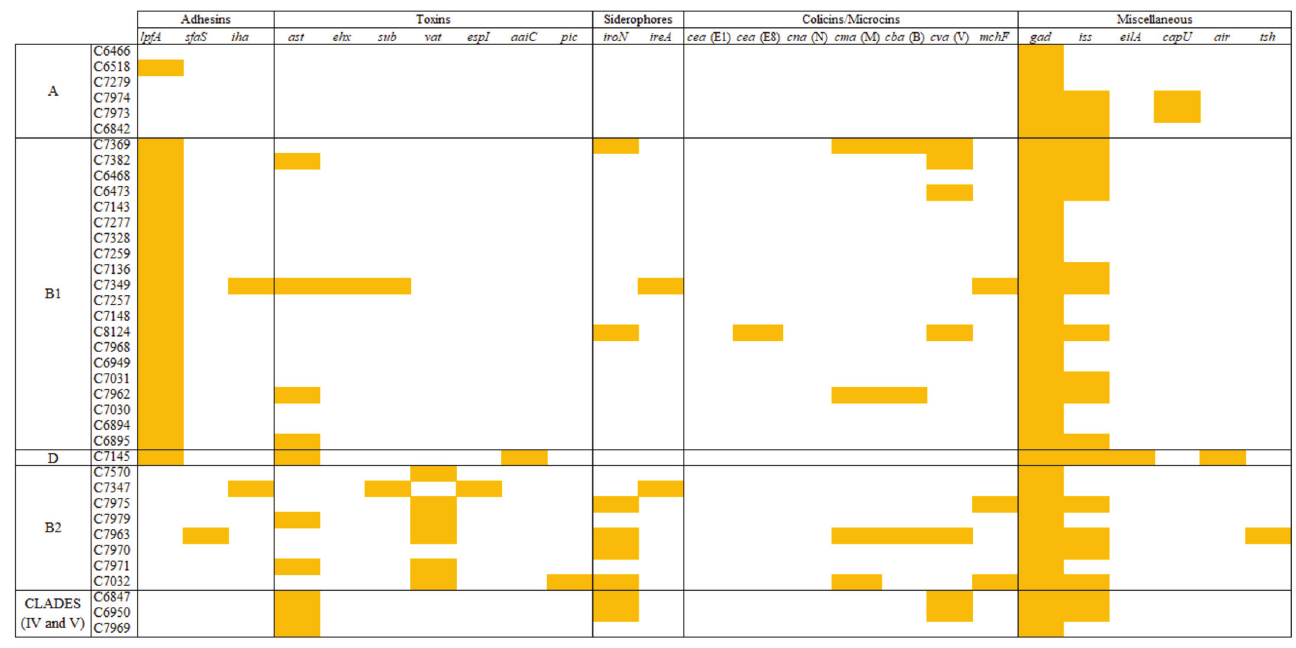
Figure 5. Distribution of the virulence determinants among E. coli